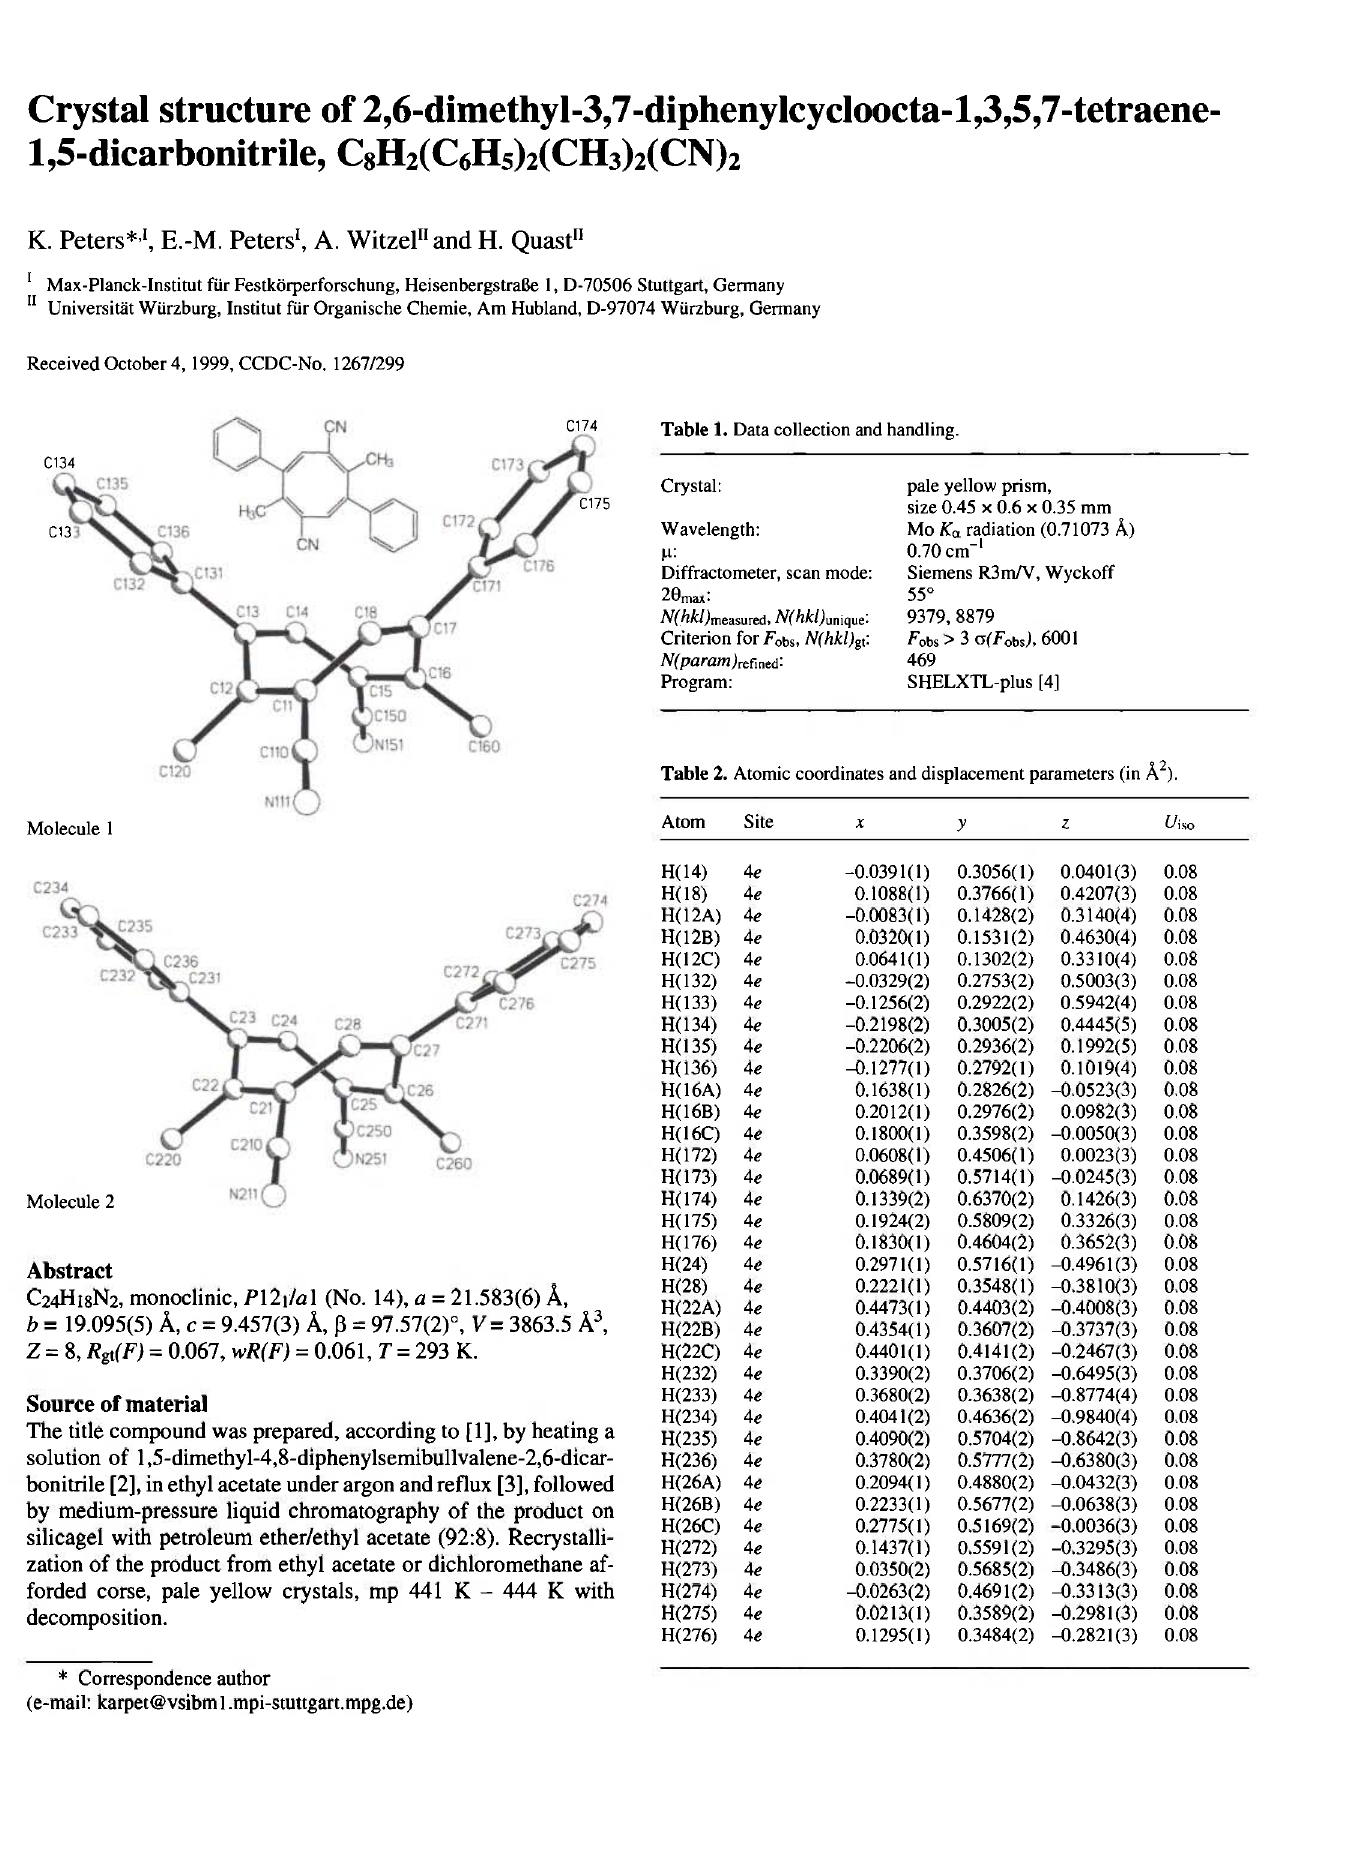
Table 1. Data collection and handling.